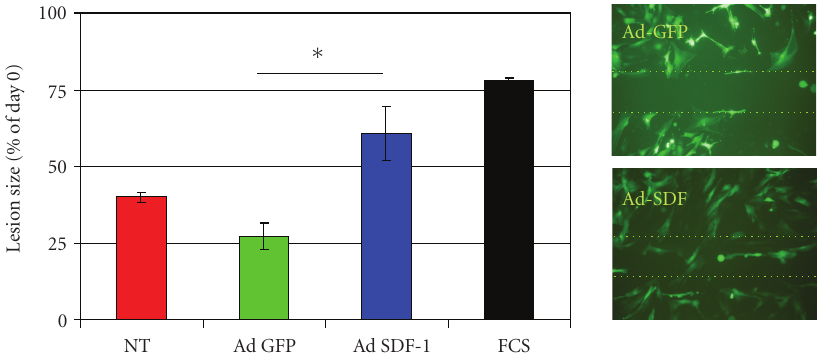
Figure 1: In vitro lesion repair assay. Lesion closure (expressed as % of the area at day 0) in an in vitro lesion repair assay. Nontransduced AT-SCs (NT) or transduced with an adenoviral vector expressing GFP (Ad-GFP) or expressing SDF-1 and GFP (Ad-SDF-1) were maintained in serum-free medium supplemented by 0.1% BSA. Control cells were grown in complete medium (DMEM-20% FCS). Data are expressed as mean ± SEM, and experiment was performed in triplicate. Statistical significance level was set at P < . 05. No statistically significant di ff erence was assessed between the NT and Ad-GFP-transduced groups. At 48 hours, lesion repair in the Ad-SDF-1 group was improved in comparison with both NT group ( P = . 018) and Ad-GFP ( ∗ P = . 006). Representative fluorescence micrographs of lesion area (dotted lines) at day 2. Original magnification